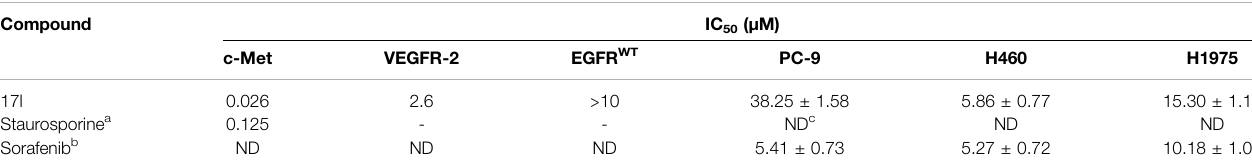
TABLE 2 | Antiproliferative and some other kinase inhibitory activities of compound 17l.